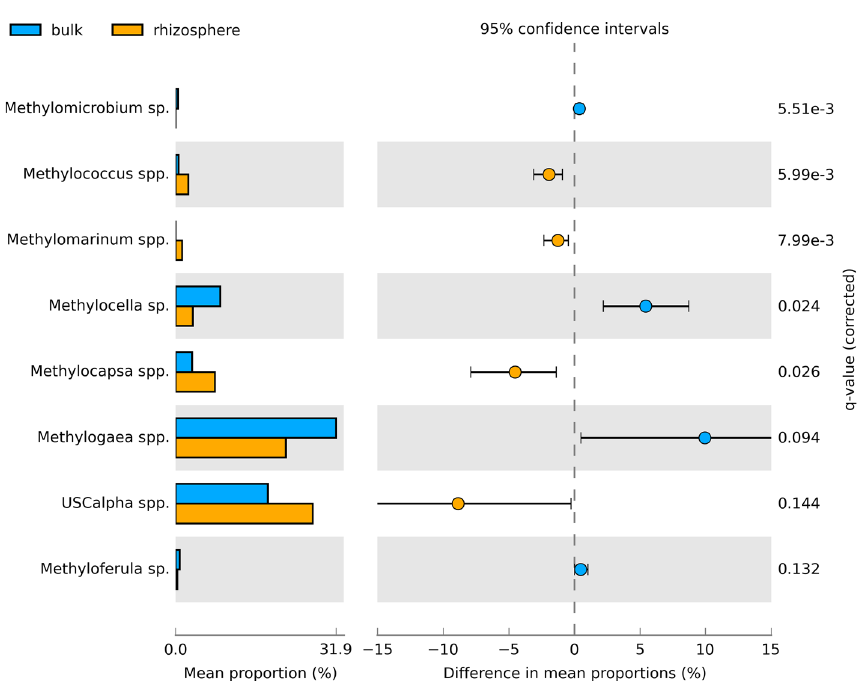
Figure 8. Extended error bar plot showing mean proportions [%] of methanotrophs and indicating differences in mean proportions [%] related to bulk soil (blue) and rhizosphere soil (orange). q-values are adjusted p-values following Benjamini–Hochberg method for multiple test correction. Features with confidence intervals on the positive or negative side only are shown which mainly corresponds to a significance level of p ≤